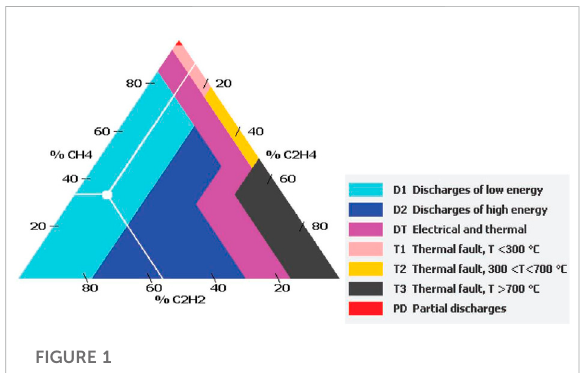
FIGURE 1 Duval ’ s triangle zones showing the identi fi able fault